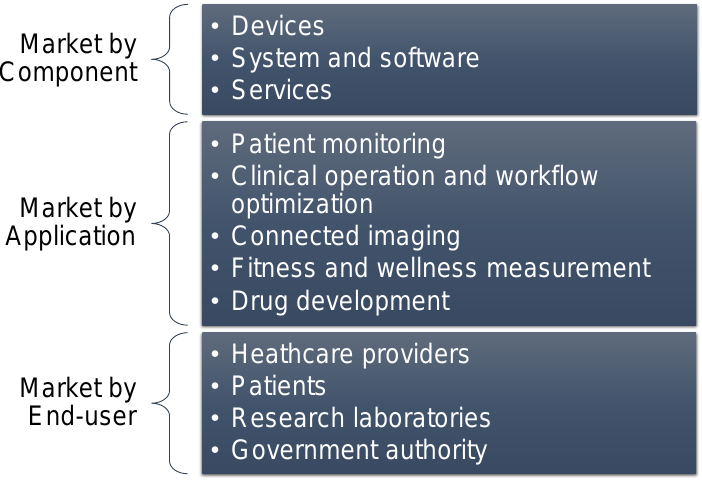
Figure 10. Latest industry trends by component, application and end-user which support the development of IoT and cloud computing in